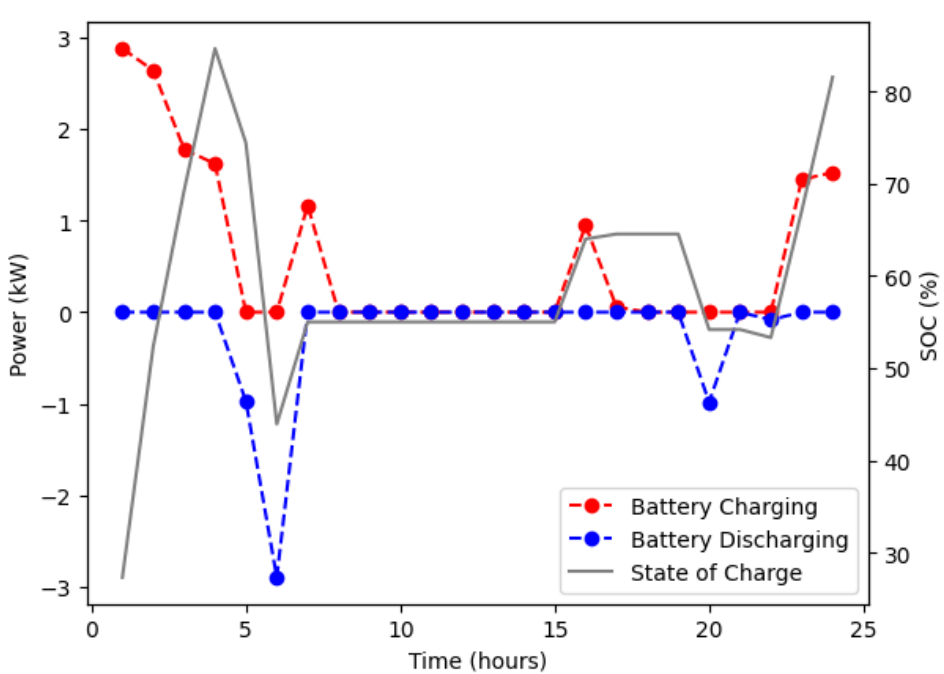
Figure 10. Battery charges and discharges on the first day after applying the